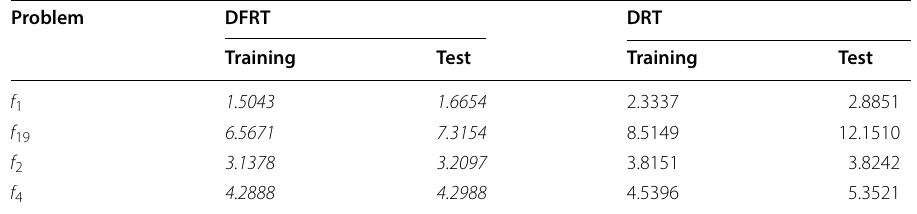
Table 5 Average MSEs obtained by DFRT and DRT on the training and test sets for the synthetic datasets